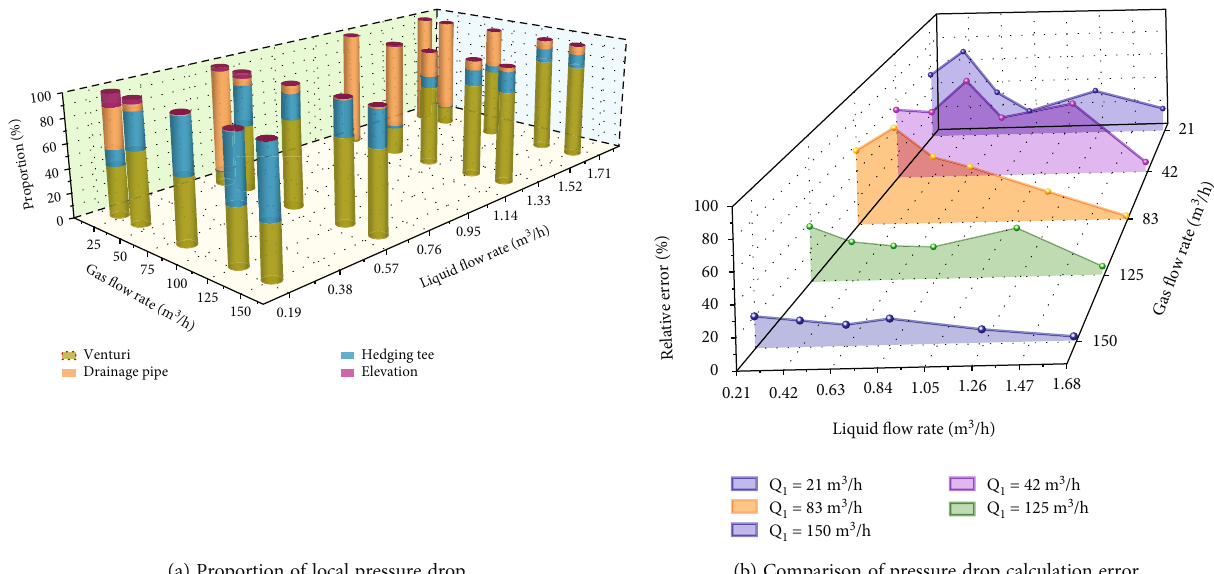
Figure 13: Comparative analysis of the error of pressure drop calculation under di ff erent gas-liquid ratio conditions.